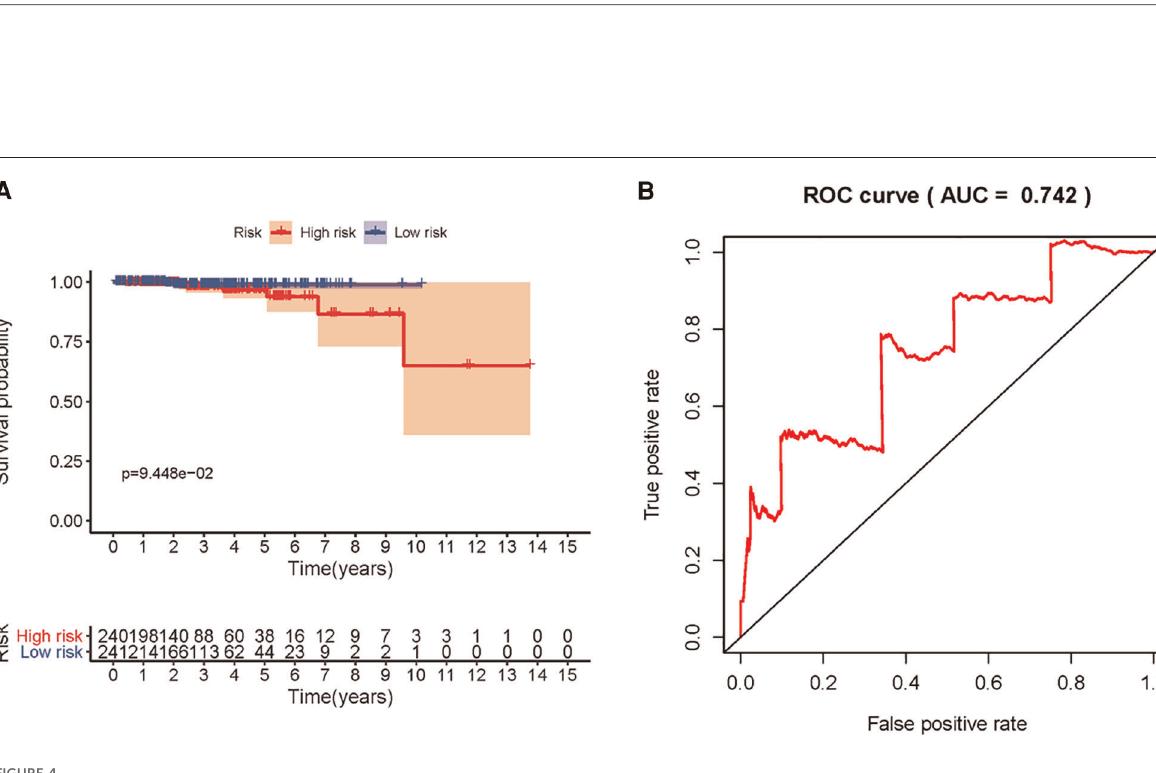
FIGURE 4 Survival curve and receiver operating characteristic (ROC) curve of RSM. (A) Kaplan – Meier survival curve of OS in low-risk and high-risk groups of PCa patients. The high-risk group demonstrated a poor prognosis for PCa patients. (B) ROC curves indicated the accuracy and sensitivity of RSM. The AUC was 0.742.